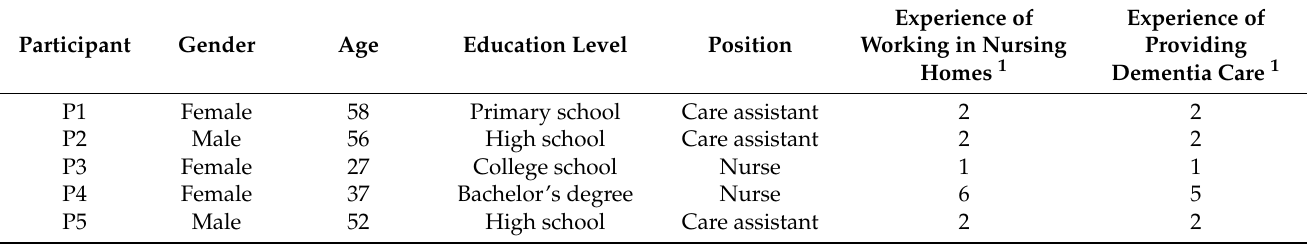
Table 2. Characteristics of participants involved in interviews in feasibility study.